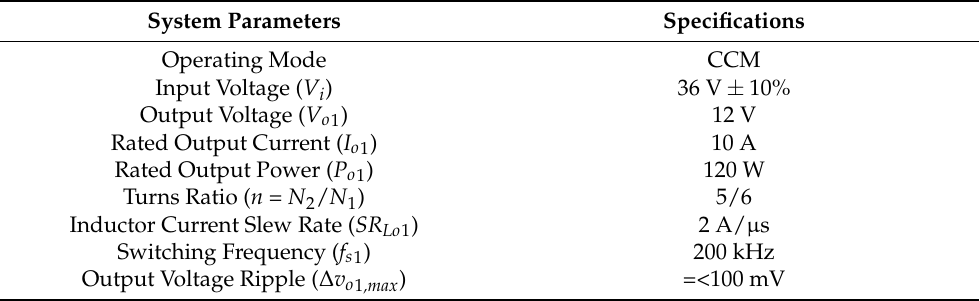
Table 1. Main output specifications.